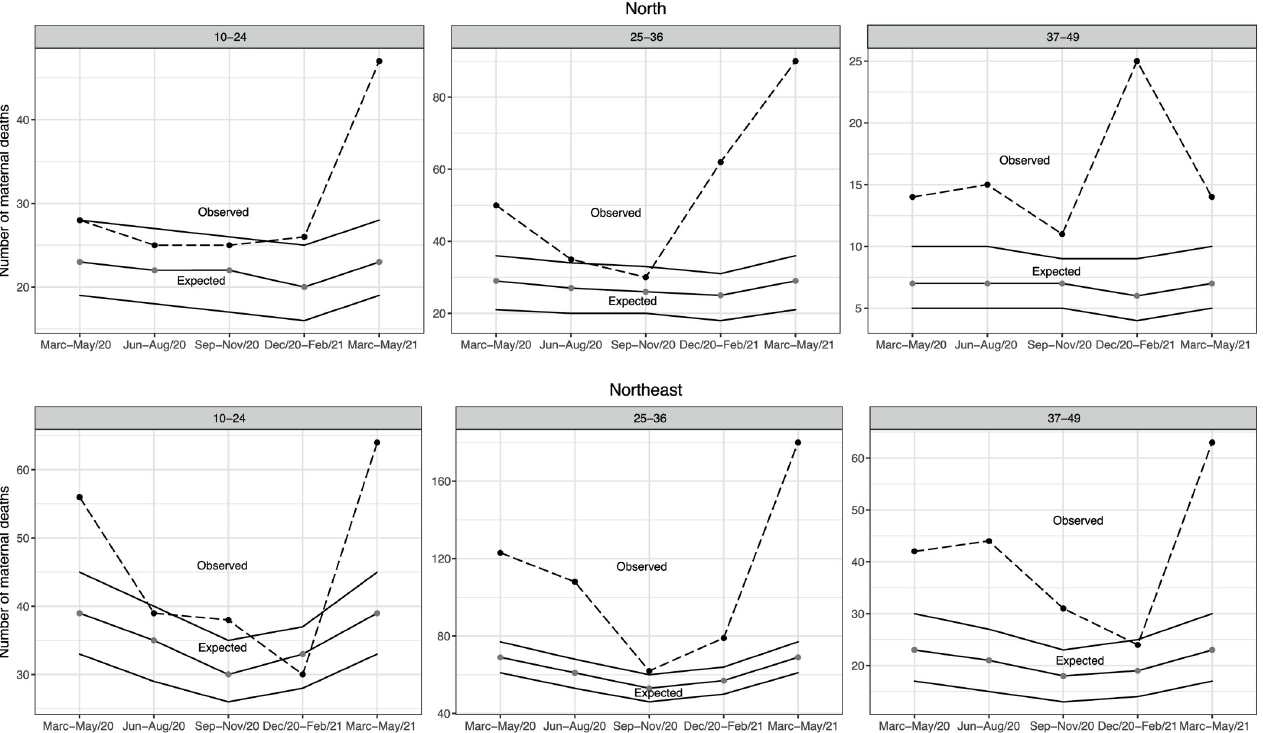
Fig 1. Observed and expected maternal deaths according to age group and five consecutive trimonthly periods, North and Northeast regions, Brazil 2020– 2021.